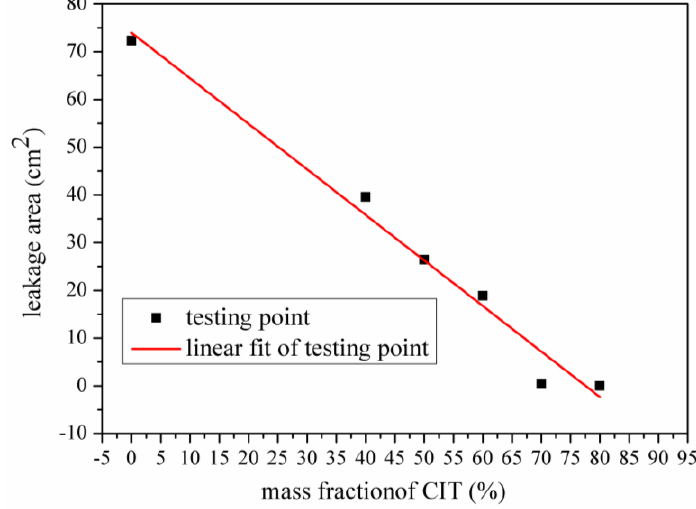
Figure 6. Leakage ratios of CA/CIT composites with different mass fractions of CIT.